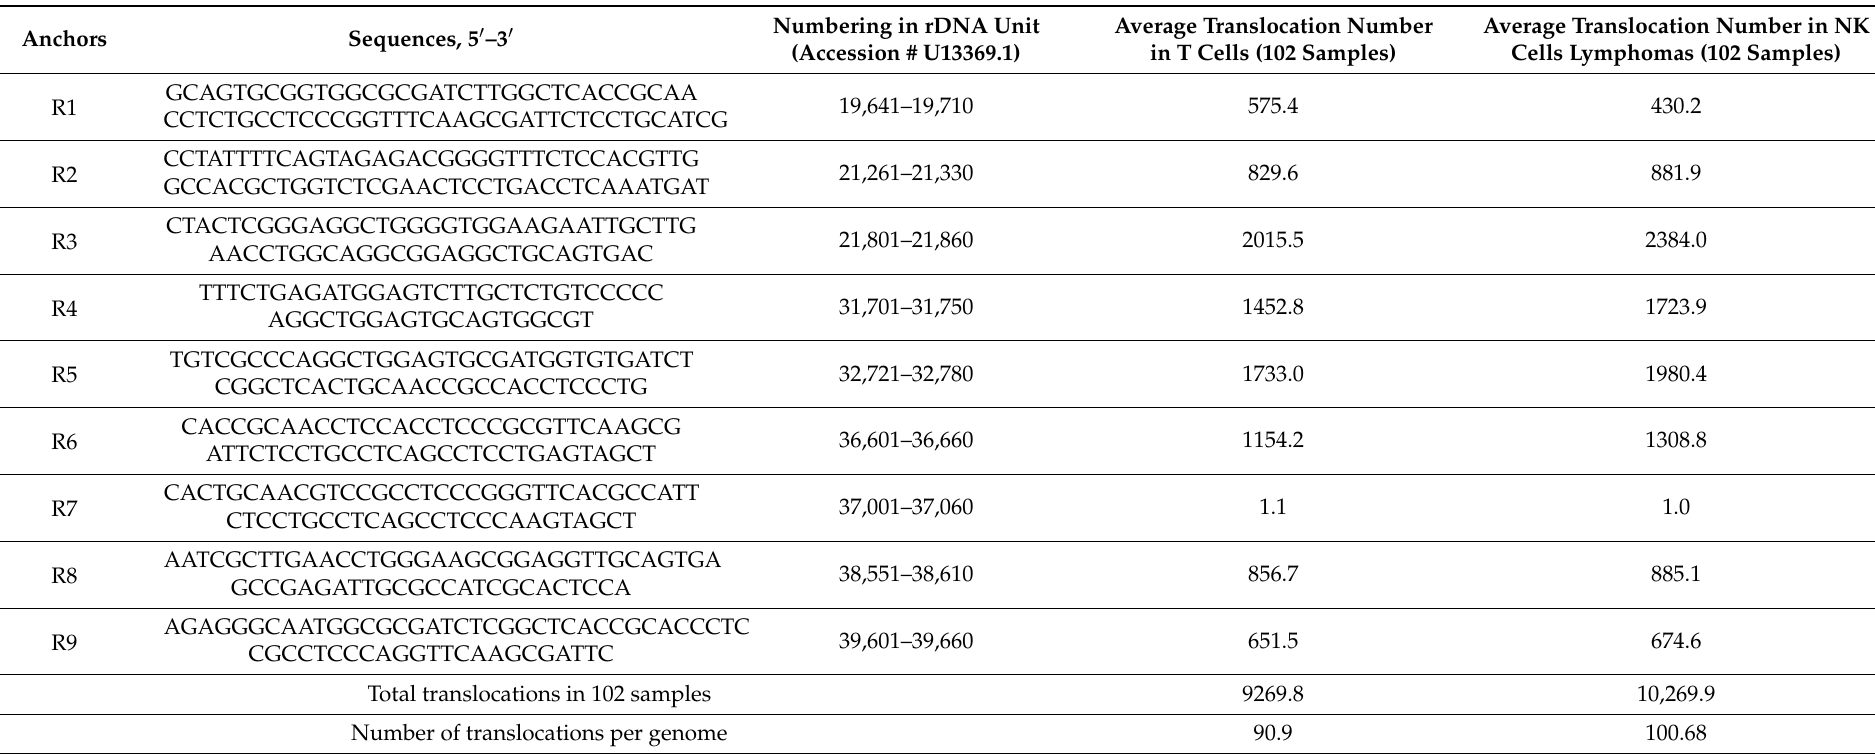
Table 1. rDNA sequences (anchors) used for searching for rDNA-mediated translocations and the detected frequencies of the translocations in T cells and NK-cell lymphomas.